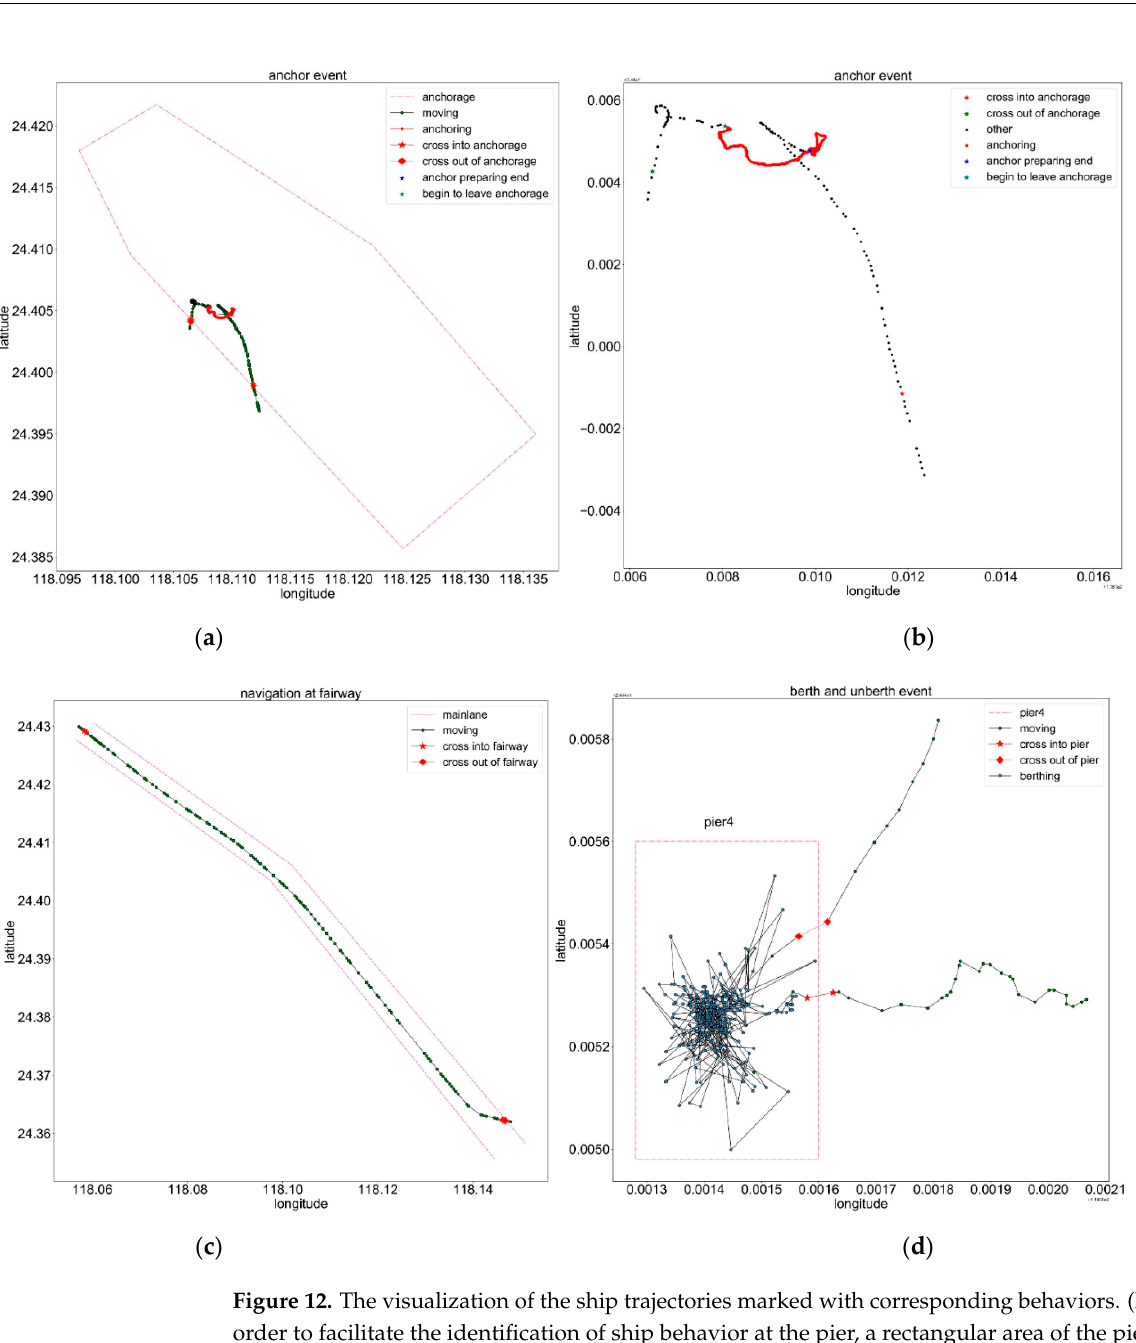
Figure 11. The reasoning results of activity behavior cross_into_lan e.